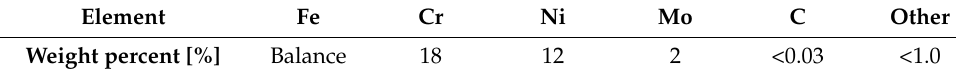
Table 1. Chemical composition of MetcoAdd TM 316L-A powder [42].